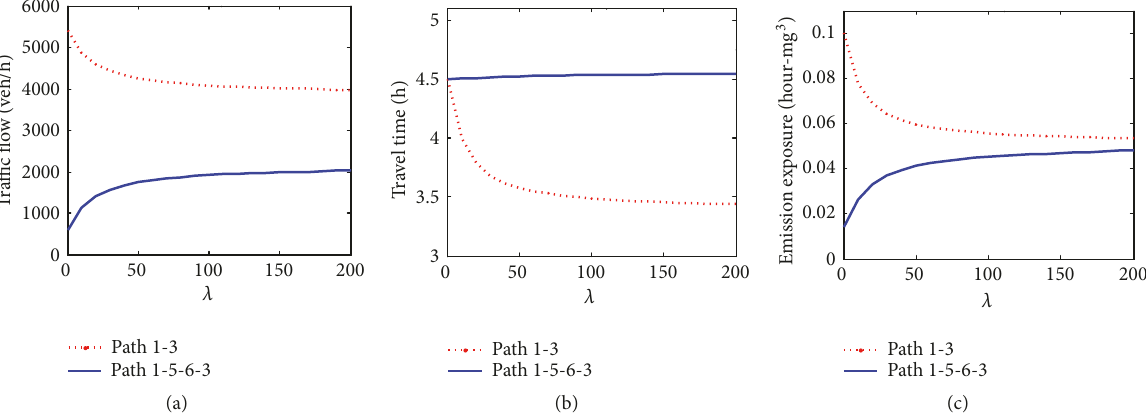
Figure 3: Path-based results of the environmental advocacy UE: (a) traffic flow; (b) travel time; (c) emission exposure.